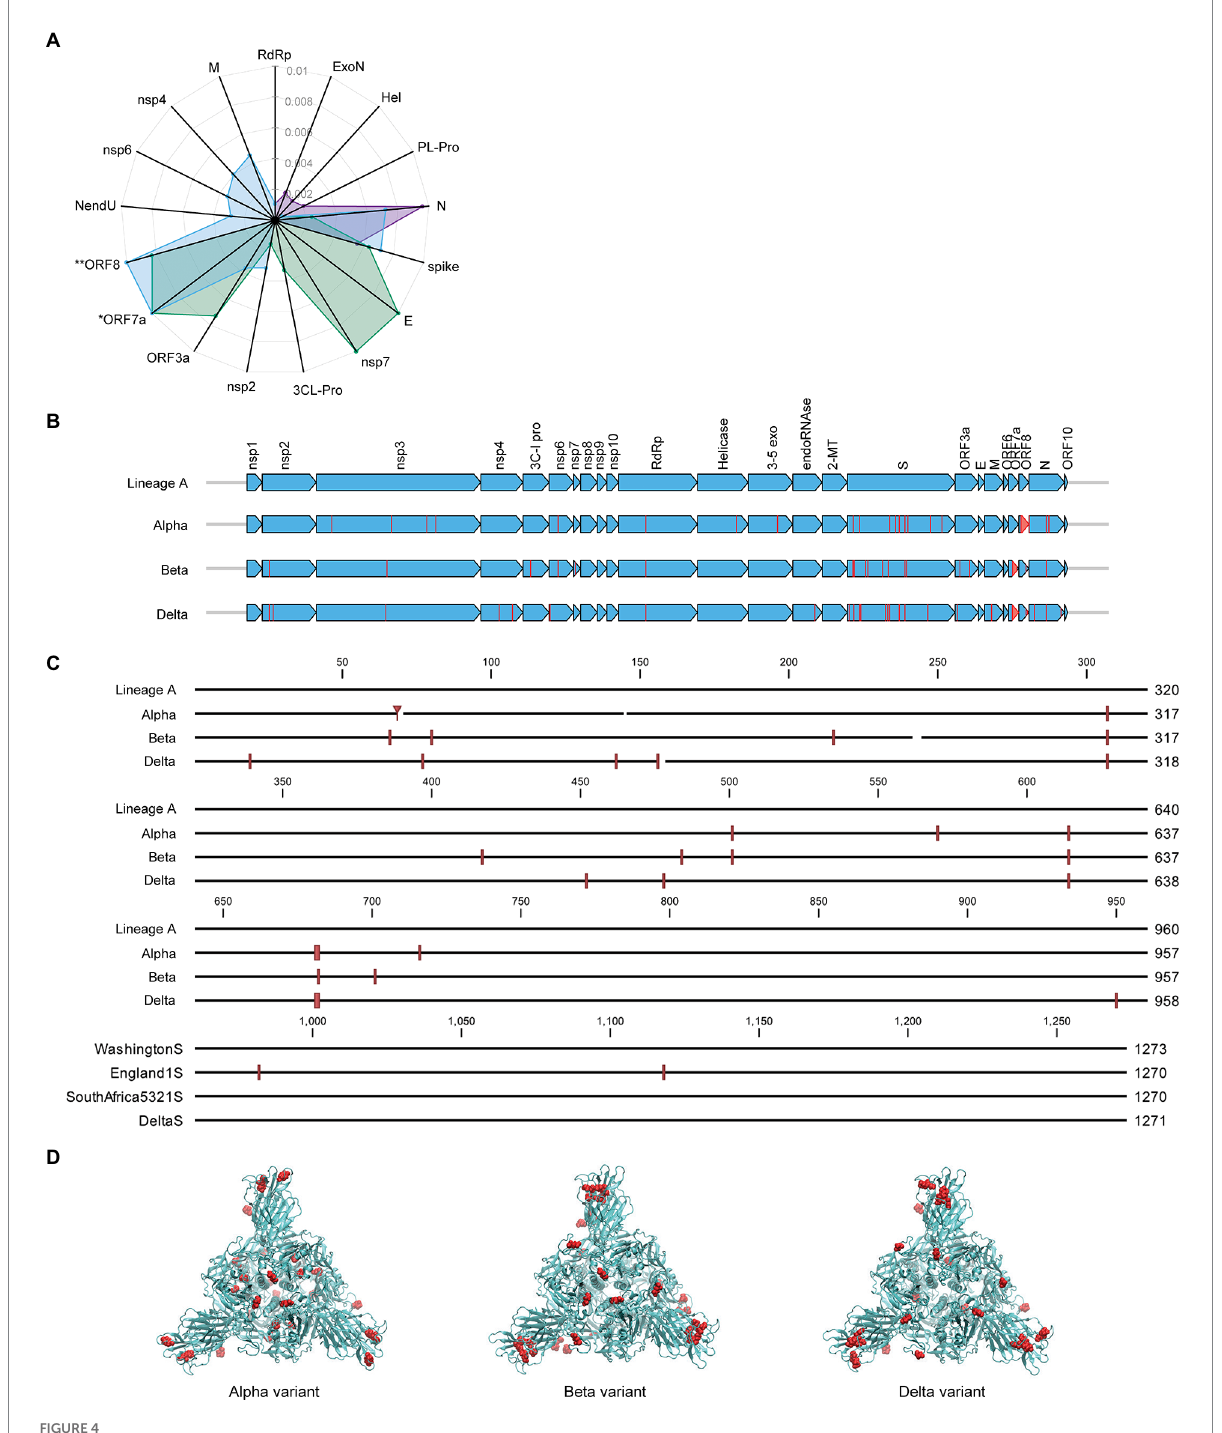
FIGURE 4 Comparison of mutation status of SARS-CoV-2 variants. (A) Radar plot displaying estimated protein sequence evolutionary distance to the Lineage A variant for the Alpha (purple), Beta (green), and Delta (blue) variants. Only proteins that contain substitutions in at least one of the variants are shown. Proteins are ordered to group similar distances together for each isolate. *Delta ORF7a protein sequence has an estimated distance of 0.67 from Lineage A due to a deletion resulting in a frameshift. **Delta ORF8 protein sequence has an estimated distance of 0.02 from the Lineage A variant. These distances are plotted at the limits of the plot for clarity. (B) Comparison of the SARS-CoV-2 proteome across the four variants of varying lineage used in this study. Arrows indicate all proteins encoded by the SARS-CoV-2 genome, and vertical lines denote amino acid variations with respect to the Lineage A variant. (C) Multiple alignment of SARS-CoV-2 spike protein sequences for the four variants shown in (B) displayed in greater detail. Amino acid variations with respect to the Lineage A variant are indicated with red vertical lines. (D) Spike protein homotrimer homology model of Lineage A variant with amino acid variations colored red for the Alpha, Beta, and Delta